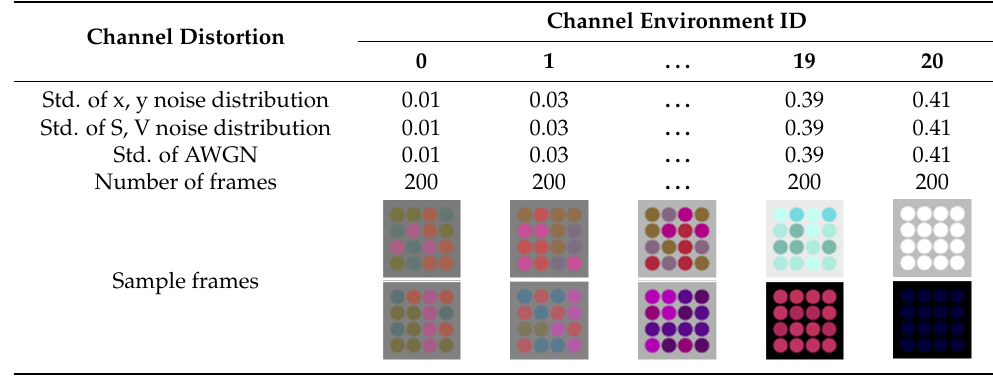
Table 6. Verification data information.